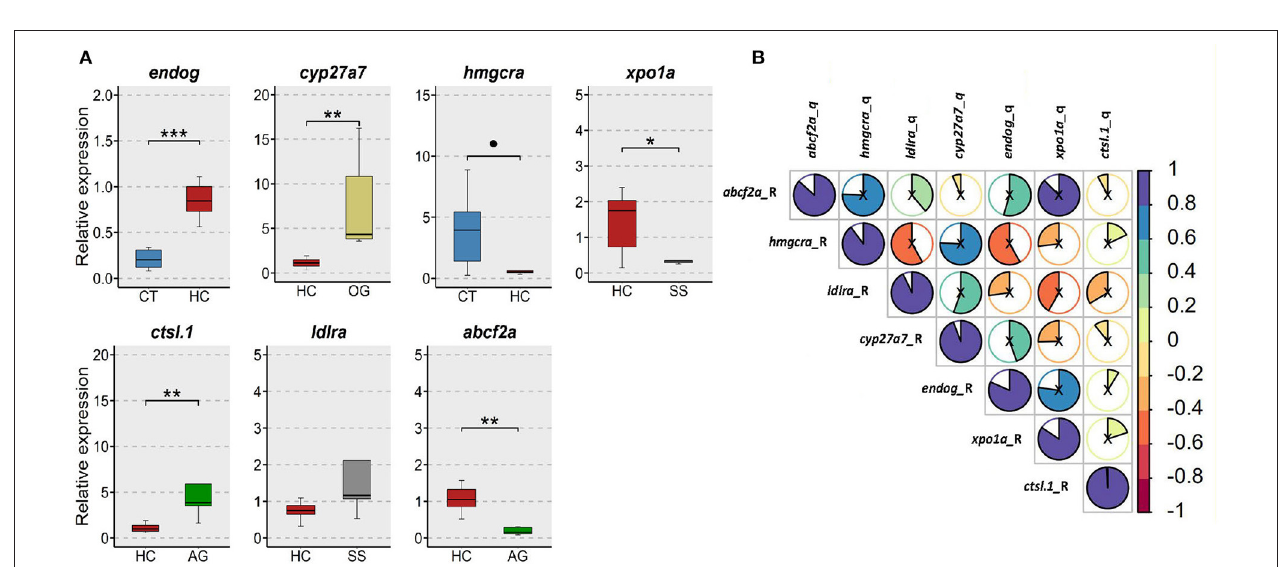
FIGURE 11 | Verification of the expression of selected genes from the transcriptomic data. (A) Relative expression of 7 selected genes in the intestine of the zebrafish. CT, fish fed low cholesterol; HC, fish fed high cholesterol; AG, fish fed algal glucan; OG, fish fed oat glucan; SS, fish fed simvastatin. n = 5. *** indicate p < 0.001, ** indicates p < 0.01, * indicates p < 0.05, and • indicates p < 0.1. Each treatment group consisted of five biological replicates. (B) Correlation between the normalized counts from the RNA-Seq data and relative gene expression from the qPCR